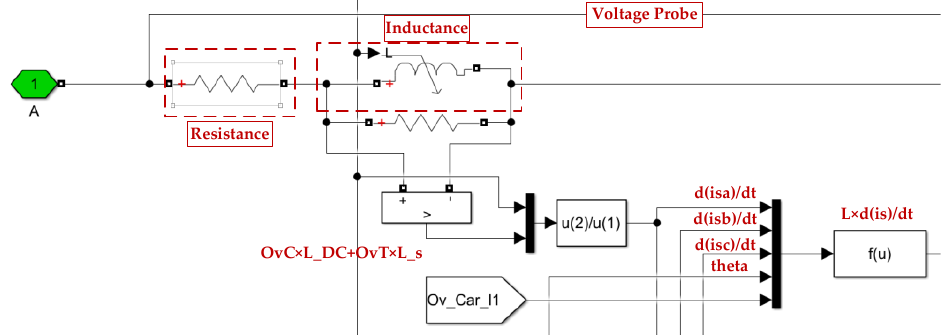
Figure 7. Part B of the motor model.